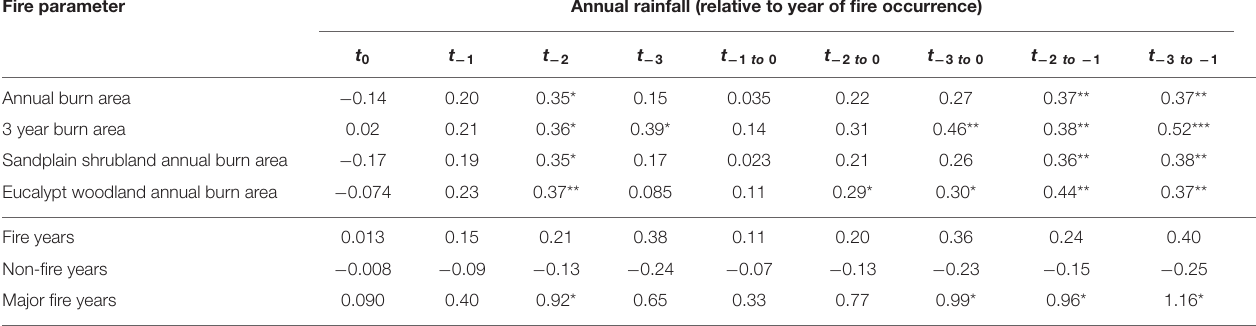
TABLE 4 | Fire–rainfall relationships shown for single year and multi-year (cumulative) totals using (1) correlations between annual burn areas and annual rainfall (upper half of table); and (2) anomalies between mean annual rainfall associated with fire event year(s) and long-term regional averages (1968–2018) expressed as standard scores (lower half).